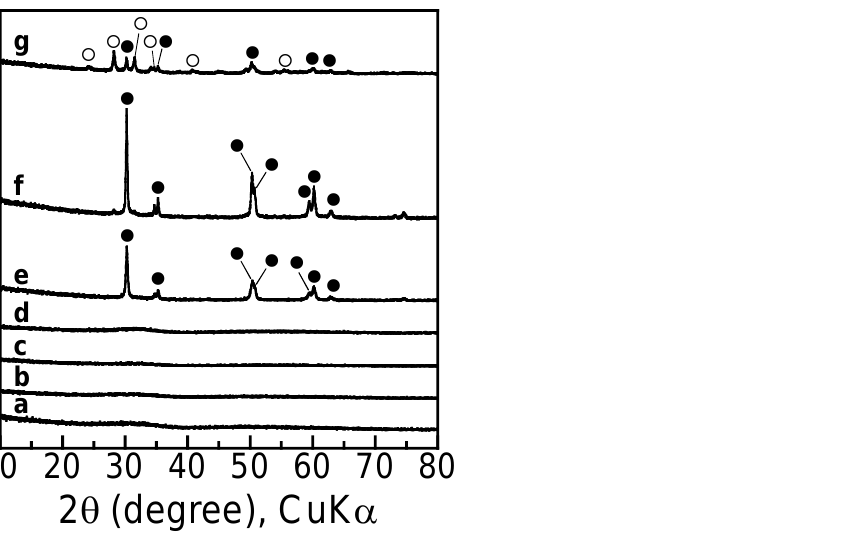
Figure 2. XRD patterns of sol – gel products ( a ) as-prepared and annealed at ( b ) 100, ( c ) 200, ( d ) 300, ( e ) 400, ( f ) 500, and ( g ) 600 o C. ●: t -ZrO 2 , 〇 : m-ZrO 2 .